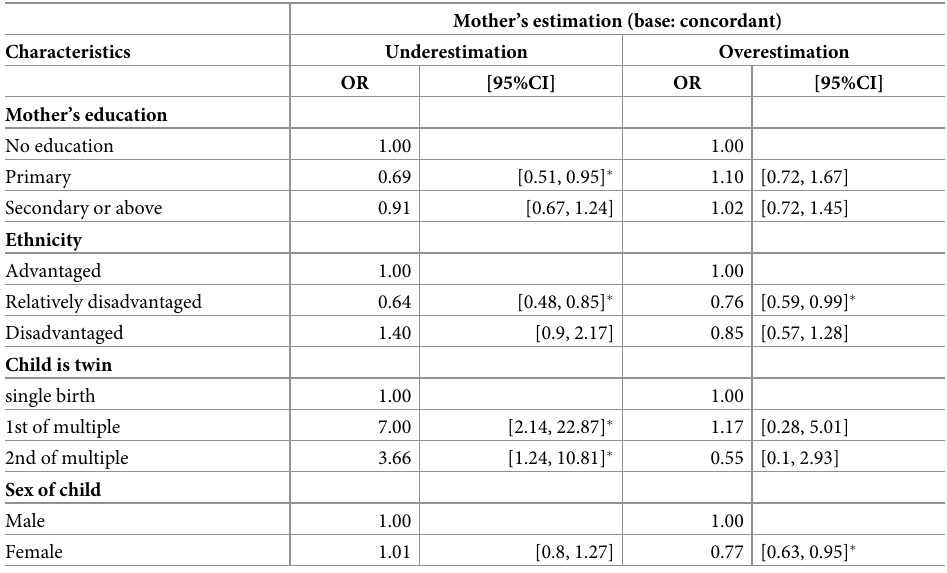
Table 4. Factors associated with discordance between mother’s perception of size at birth and birth weight, NDHS 2016, N = 3095. Mother’s estimation (base: